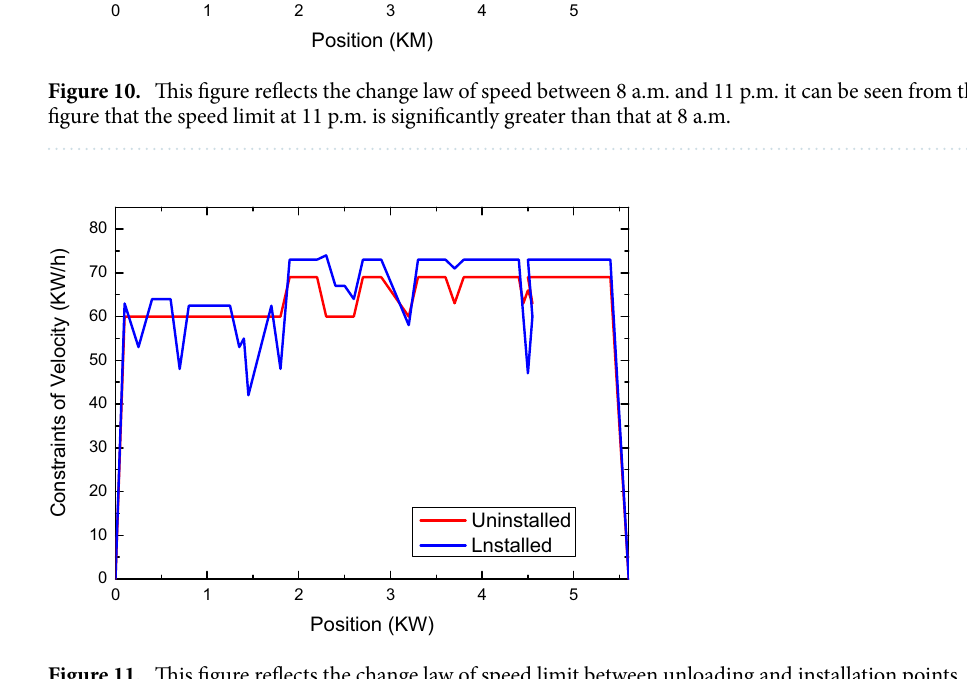
Figure 11. This figure reflects the change law of speed limit between unloading and installation points. It can be seen from this figure that the change of unloading speed limit is stable and the speed limit fluctuates greatly during